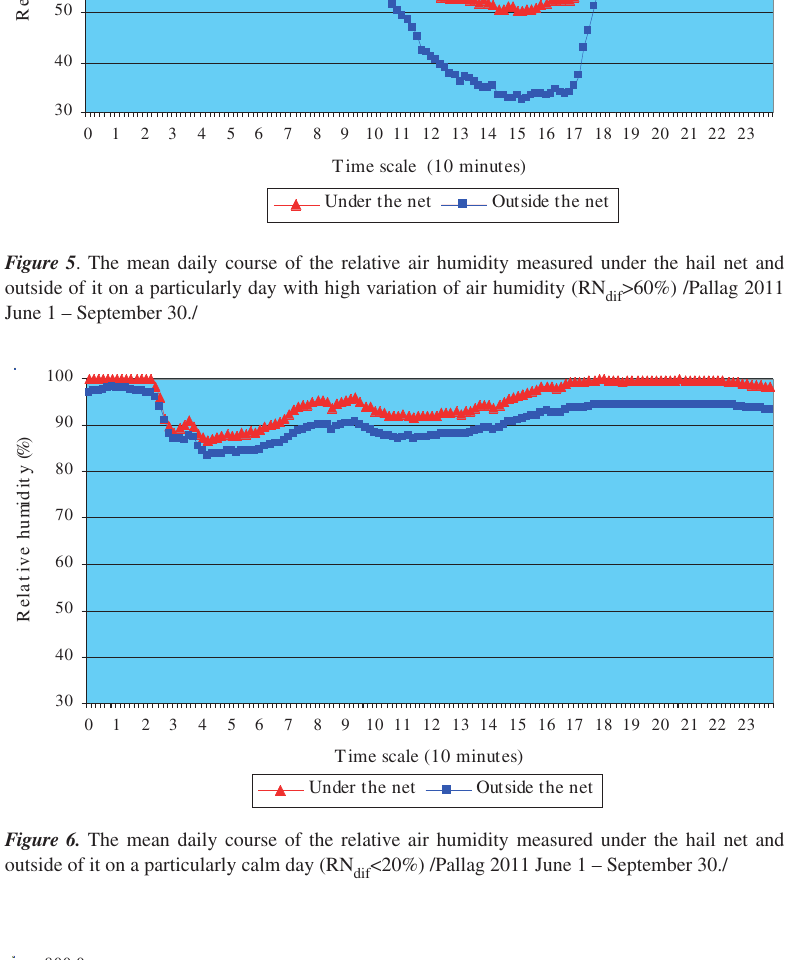
0,0100,0200,0300,0400,0500,0600,0700,0800,001234567891011121314151617181920212223 Timescale(10minutes) G l ob a l r a d i a ti on ( W / m 2 ) UnderthenetOutsidethenet